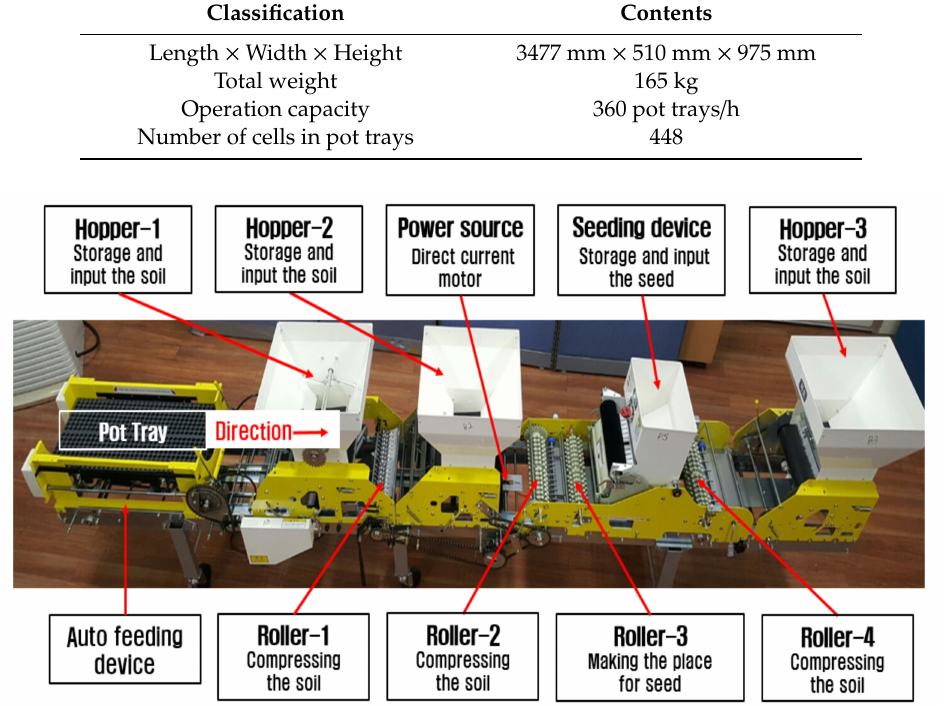
Figure 1. Picture of existing roller-type onion pot-seeding